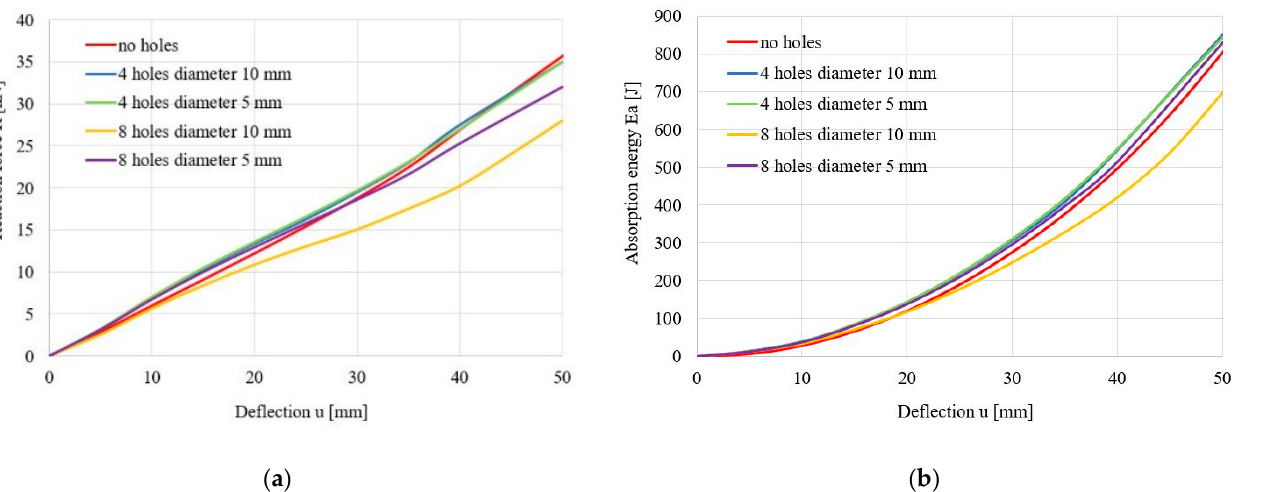
Figure 9. Numerically determined basic operational parameters of a cylindrical fender 100 mm × 50 mm × 500 mm with additional holes introduced. ( a ) Reaction force R (kN); ( b ) Absorption energy Ea (J).